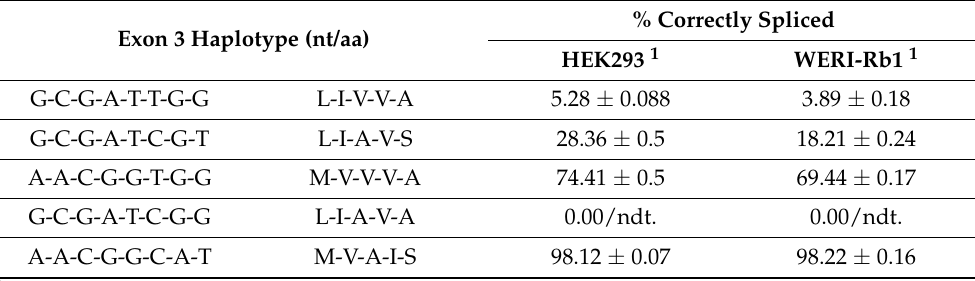
Table 2. Splicing of OPN1LW and OPN1MW exon 3 haplotype minigene constructs in HEK293 and WERI-Rb1